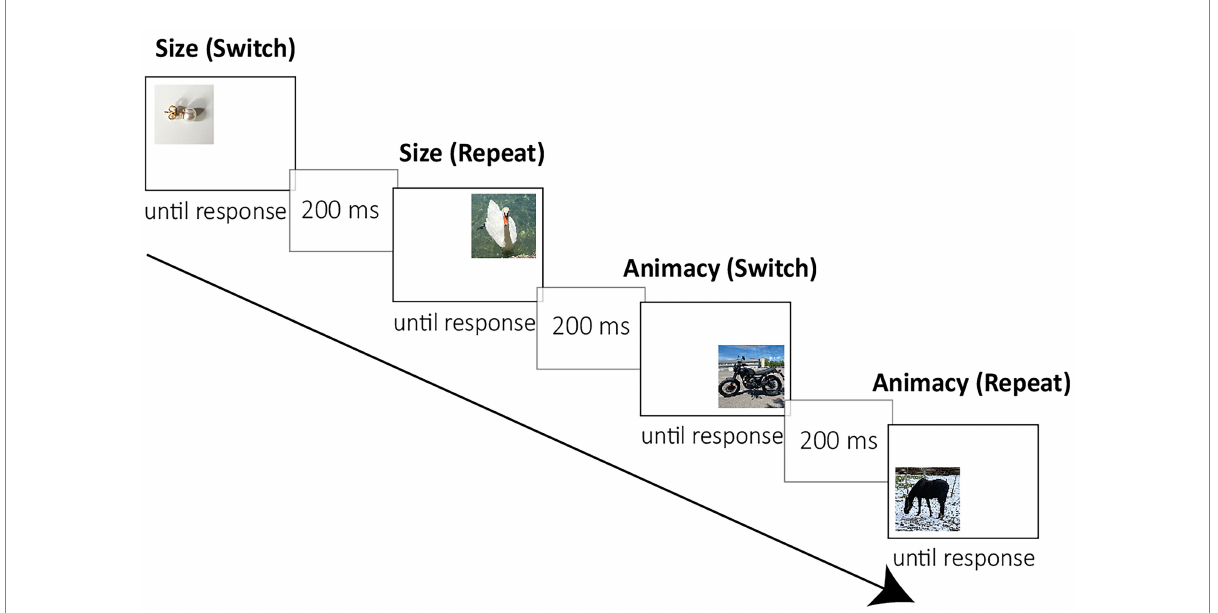
FIGURE 1 Example of a study trial sequence. The participants had to switch between two tasks in a predictable AABB order. All the stimuli were bivalent (that is, they could be used for both tasks). All the images in the figure are photographs taken by